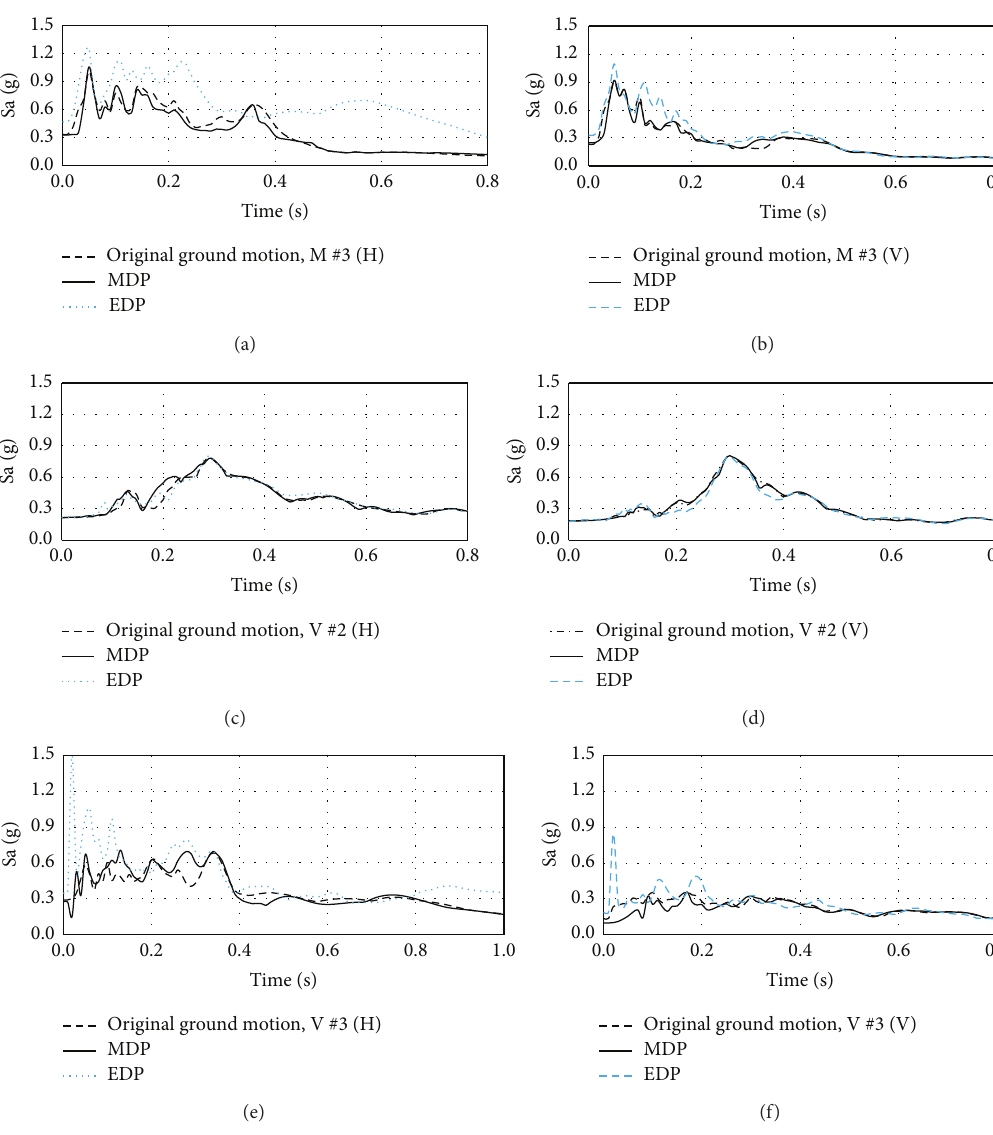
Figure 6: Response spectra of the original and deconvolved ground motions for G-1 in Montreal: (a) M number 3(H); (b) M number 3(V); (c) V number 2(H); (d) V number 2(V); (e) V number 3(H); and (f) V number